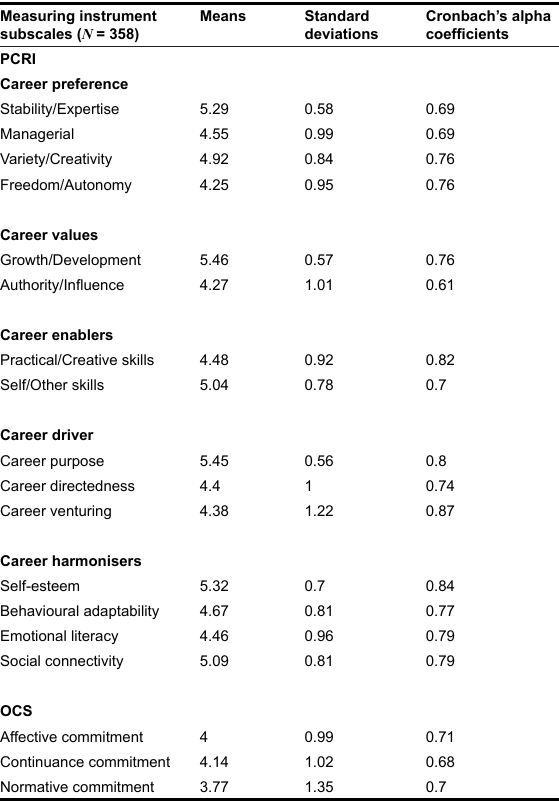
TABLE 1 Descriptive statisctics: PCRI and OCS